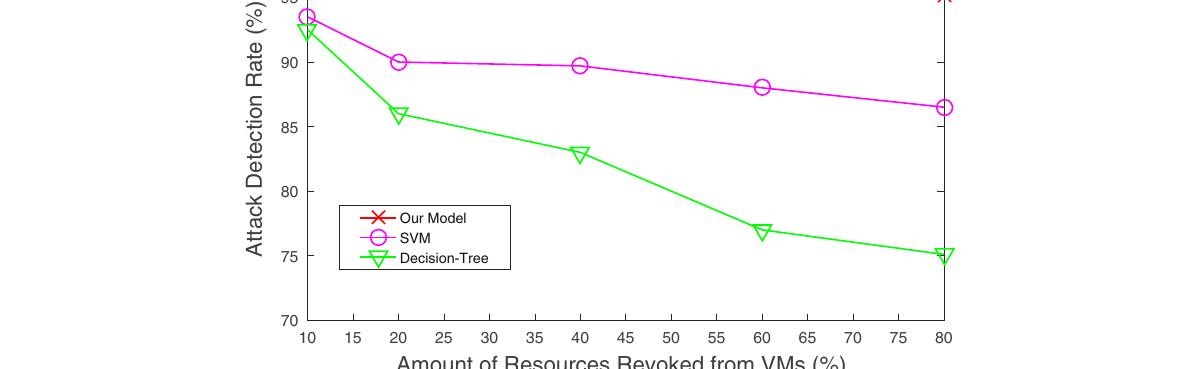
Fig. 5 Attack detection rate w.r.t. amount of revoked resources